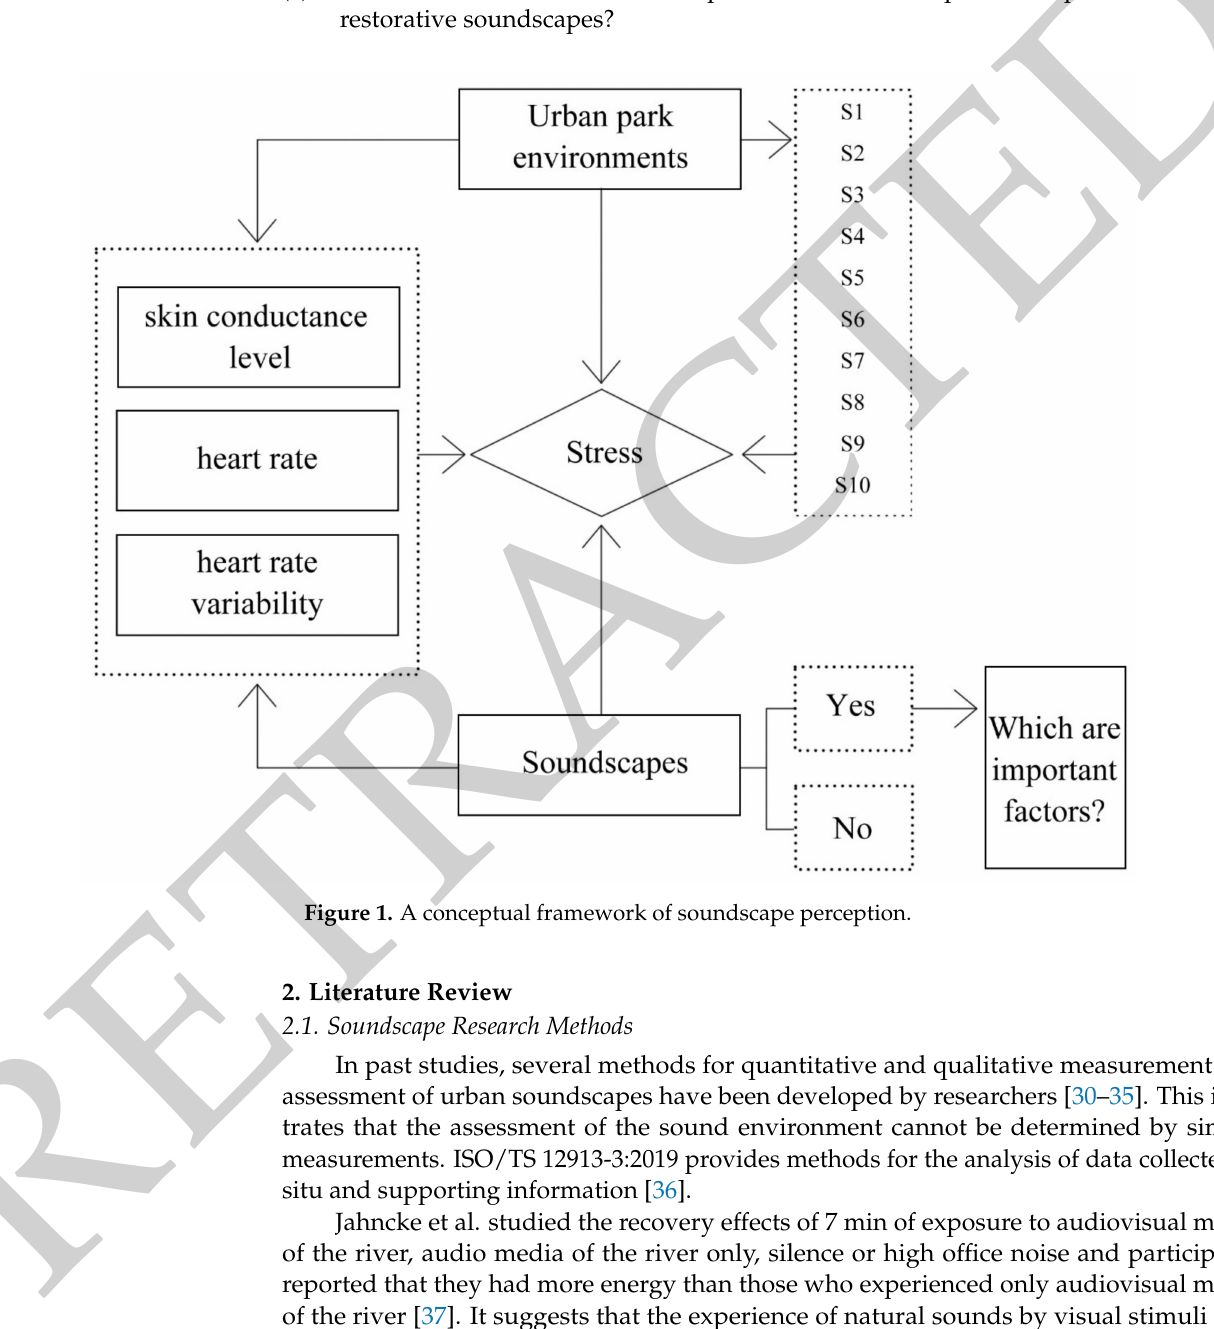
Figure 1. A conceptual framework of soundscape